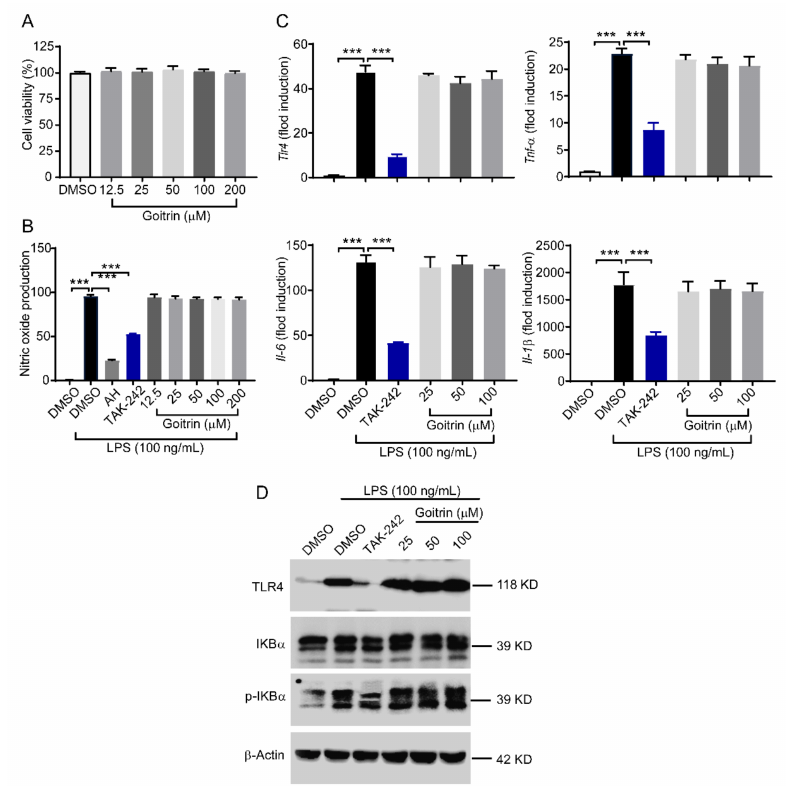
Figure 6. Effects of goitrin on the activation of TRL4 in LPS-stimulated RAW 264.7 cells. ( A ) CCK-8 assay. RAW264.7 cells were treated with goitrin at different concentrations (12.5, 25, 50, 100, or 200 µ M) for 24 h ( n = 6). ( B ) Determination of NO production. RAW264.7 cells were